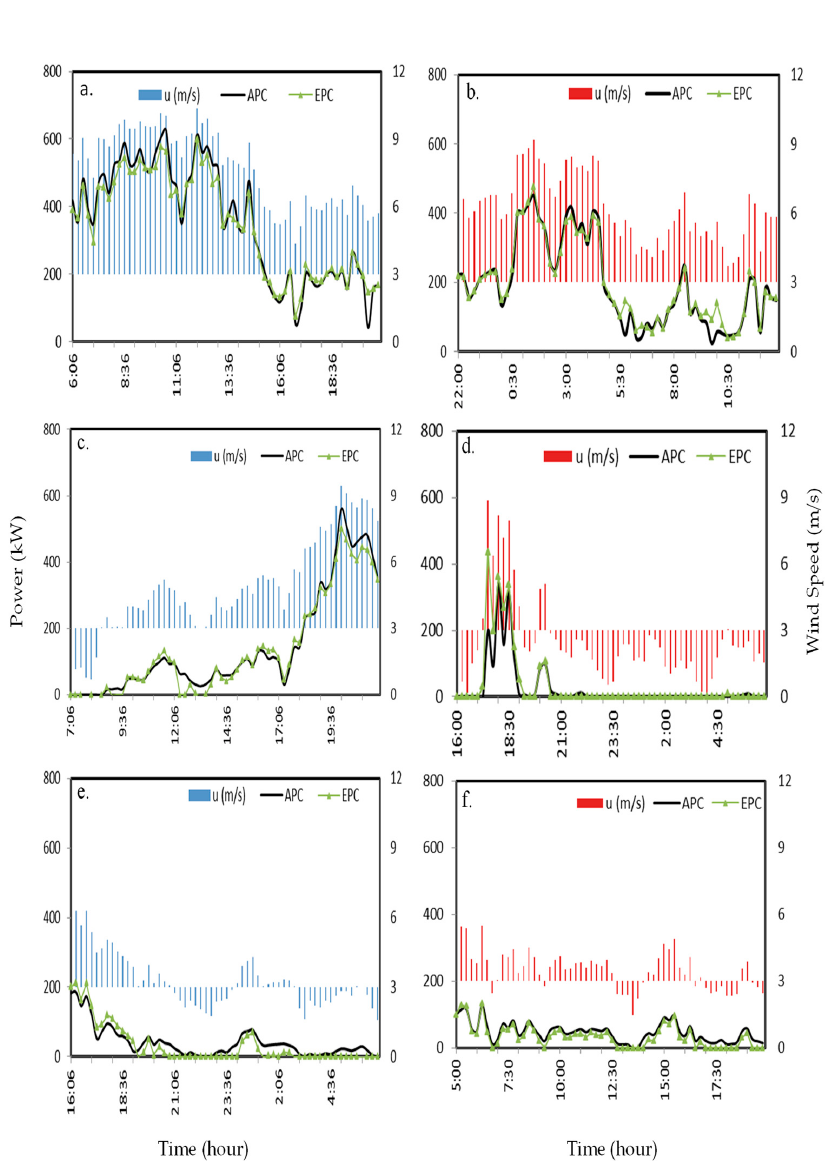
Figure 5. 15-min interval time series turbine APC (actual output) and EPC (predicted output) for: scenario A in ( a ) winter and ( b ) summer; scenario B in ( c ) winter and ( d ) summer; and scenario C in ( e ) winter and ( f ) summer, with average wind speed bars